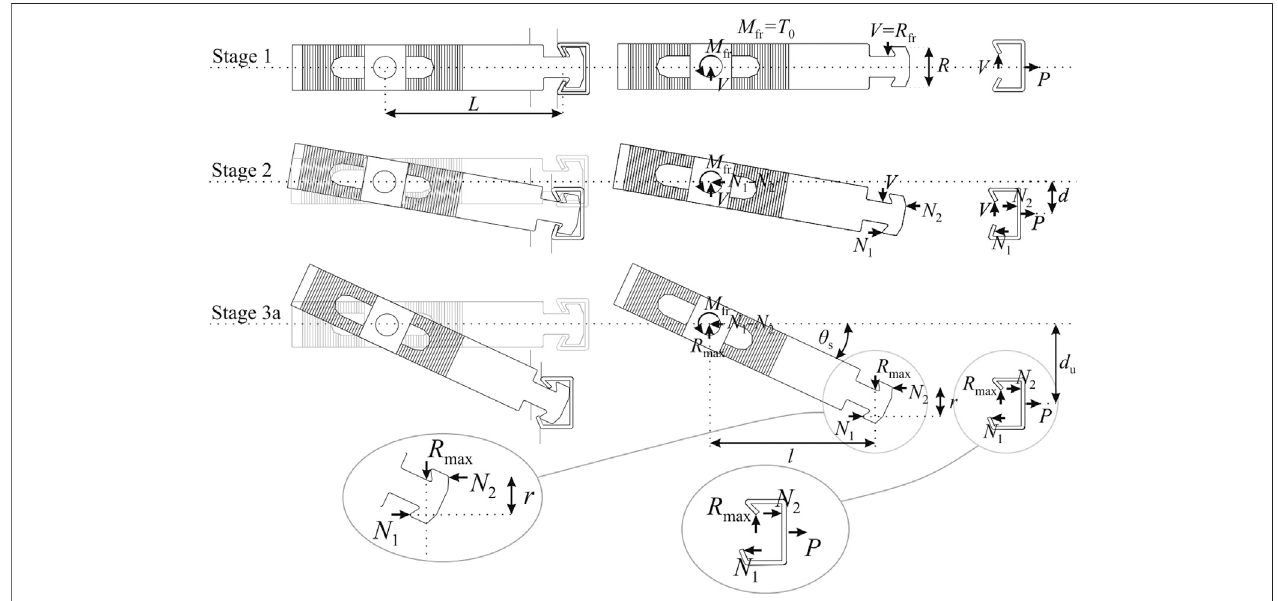
FIGURE8| Theshearforcetransfermechanismintheinvestigatedconnections,andthestateofequilibriumjustbeforefailure,adoptedfromZoubeketal.(2016a).